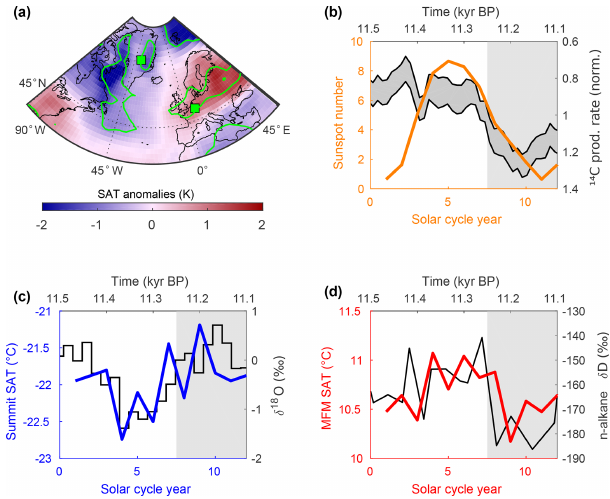
Figure 6. The 11.4ka event and MFM oscillation compared to the solar forcing of 20th century SATs in the North Atlantic region as seen in 20CR. (a) Surface air temperature (SAT) anomalies for solar maximum winters (DJF) compared to solar minimum winters (see Fig. S2) for the period 1946–2011CE in 20th century climate reanalysis (Compo et al., 2011). The green squares point to the location of Summit and of MFM, while the green contour lines represent significance levels for p < 0 . 1 ( t test). Years influenced by large tropical volcanic eruptions have been removed as per Ineson et al. (2011). (b) The transition between high to low solar activity in the 14 C production rate data (gray envelope, top and right axes) compared to the mean sunspot group number of all 11-year solar cycles between 1900 and 2011CE (orange curve, bottom and left axes). (c) The δ 18 O stack (black curve, top and right axes) shown in Fig. 3b compared to the mean SAT at Summit (blue curve, bottom and left axes) throughout all 11-year solar cycles between 1900 and 2011CE as in (b) . (d) Same as (c) but with δ D (black curve, top and right axes) and MFM SAT (red curve, bottom and left axes). Note the different timescale on the top (paleoclimate records) and bottom (reanalysis data) axes. The gray bands show the periods of low solar activity occurring in the two time periods that are compared.